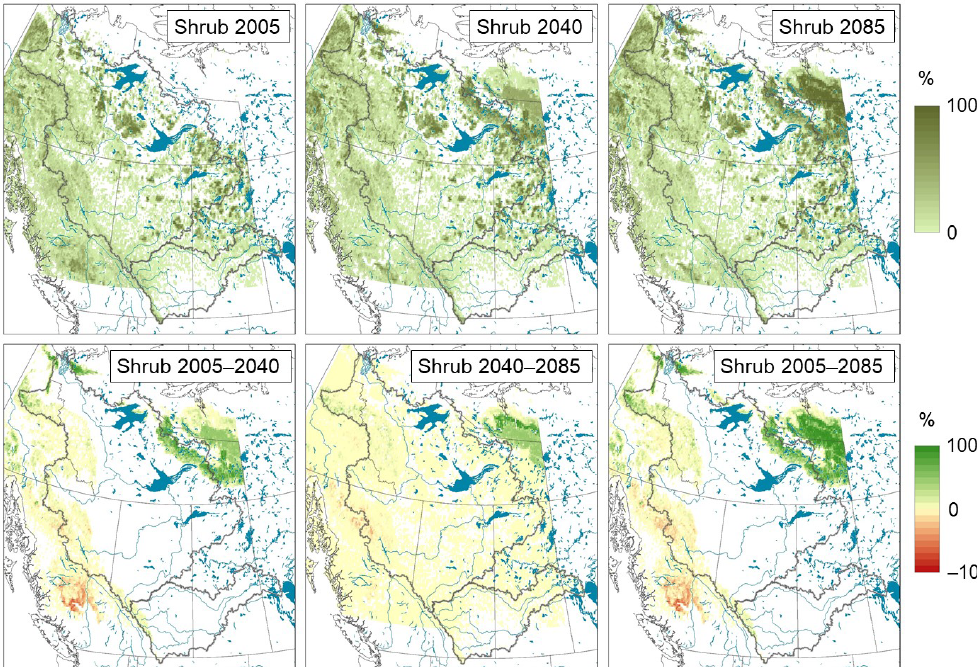
Figure 7. Changing shrub cover fractions over the Mackenzie and Saskatchewan River Basins in the 21st century derived from CCRN expert- guided modifications to climate-based projections using the methodology of Rehfeldt et al. (2012) (Appendix). Projections were made in 45-year increments from the base period (centered at 1995 but using the 2005 base map) to represent the 2040 (mid-century) and 2085 (late-century)